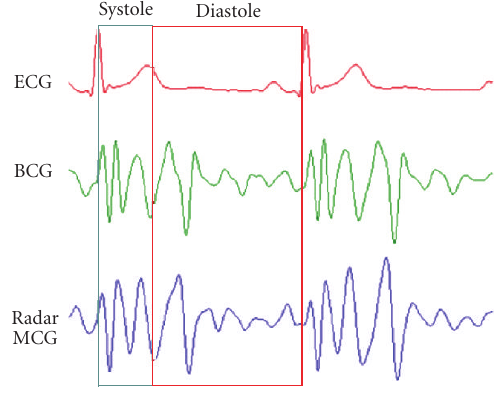
Figure 4: Two cycles of the filtered radar-based MCG signal (bottom), the filtered signal recorded directly from the sternum using a high-precision accelerometer (middle), and the lead I of ECG signal